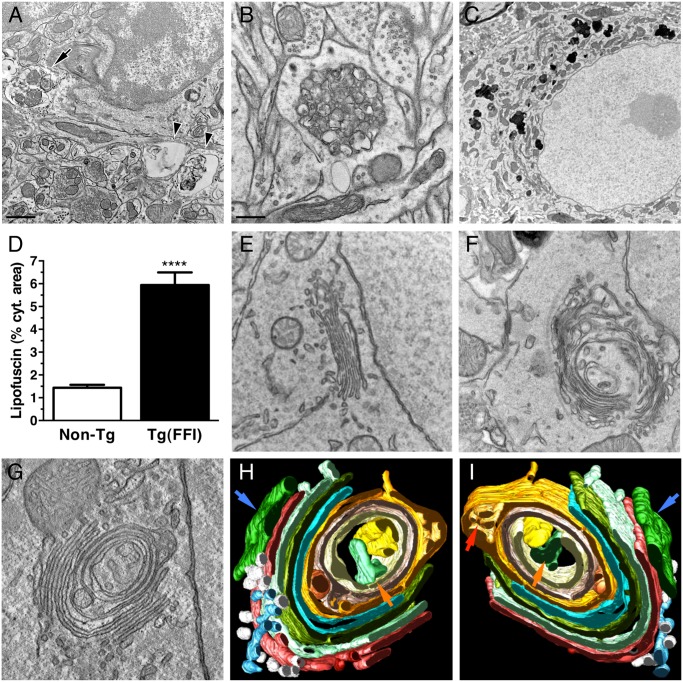
Ultrastructural abnormalities in Tg(FFI) neurons.(A) Autophagosomes in a hippocampal neuron (arrow) and the surrounding neuropil (arrowheads) of a Tg(FFI-26+/-)/Prnp
0/0 mouse at 367 days. (B) Autophagosomes and autophagolysosomes in a dystrophic cerebellar neurite of a Tg(FFI-26+/-)/Prnp
+/0 at 444 days. (C) Lipofuscin residual bodies in a thalamic neuron of a Tg(FFI-26+/-)/Prnp
0/0 mouse at 367 days. (D) Quantification of lipofuscin residual bodies in the thalamus of three non-Tg and four Tg(FFI) mice aged between 292 and 444 days. Data are the mean ± SD. ****p < 0.0001 by Student’s t test. Values from two non-Tg/Prnp
+/+ and one non-Tg/Prnp
0/0 mice, and from three Tg(FFI-26+/-)/Prnp
0/0 and one Tg(FFI-26+/-)/Prnp
+/0 mice were pooled. (E) Normal Golgi appearance in a hippocampal neuron of a non-Tg/Prnp
+/+ mouse at 280 days. Onion-like Golgi morphology in hippocampal (F) and thalamic (G) neurons of a Tg(FFI-10+/-)/Prnp
0/0 mouse at 331 days. (H, I) Three-dimensional tomography reconstruction from virtual serial slices of the Golgi shown in G. The ER cisterna is colored green (blue arrows). The trans-most cisterna is in the center of the spherical Golgi (blue-green, orange arrows). Medial Golgi cisternae show invaginations of membranes inside their lumen (red arrow in panel I). The cis-most cisterna is not visible in this Golgi stack. Scale bars = 1 μm in A and C, and 0.5 μm in B and E, F and G.